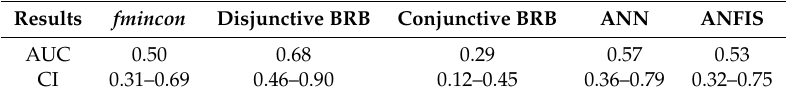
Figure 9. Receiver operating characteristic (ROC) curve comparison of fmincon , Disjunctive BRB, Conjunctive BRB, ANN, and ANFIS for predicting PUE of Facebook data center. Table 8. Comparison of area under curve (AUC) of fmincon , Disjunctive BRB, Conjunctive BRB, ANN, and ANFIS. CI: 95% confidence